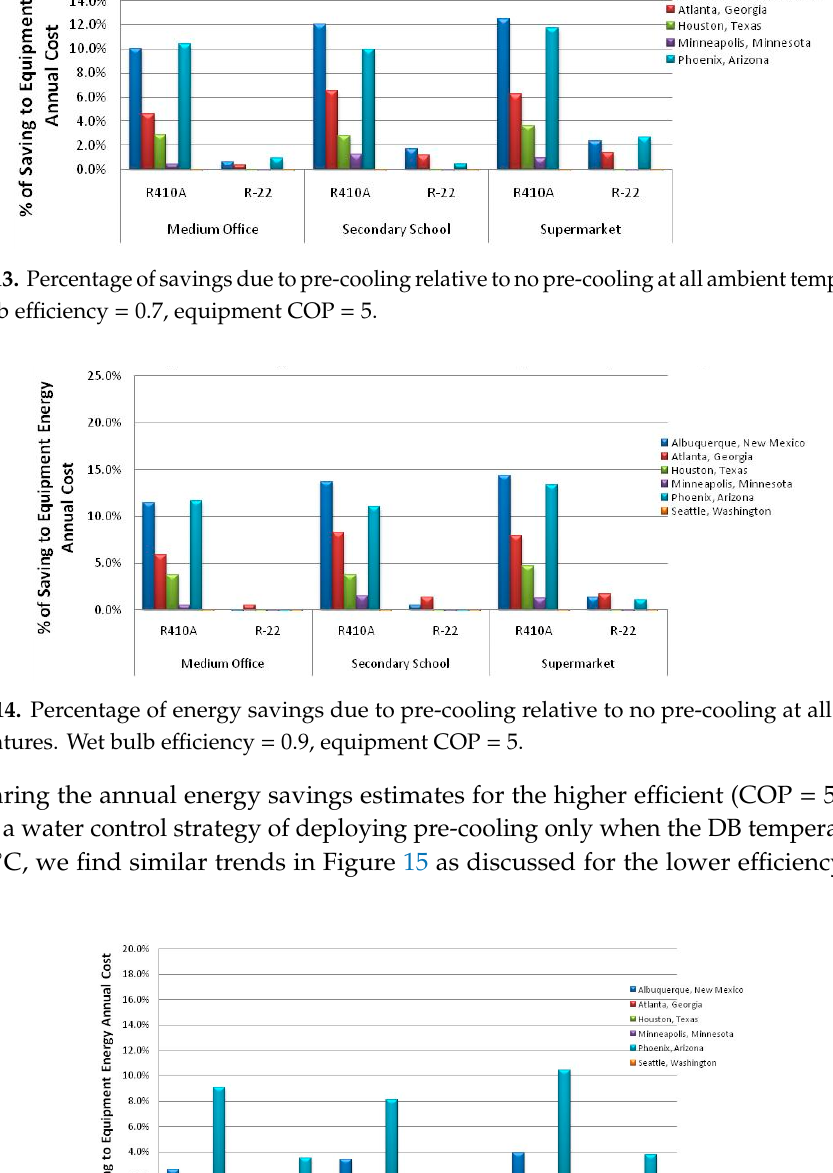
Figure 15. Percentage of energy savings due to pre-cooling relative to no pre-cooling when water is sprayed after ambient temperature is equal to or exceeds 90 °F/32.2 °C. Wet bulb efficiency = 0.9, equipment COP = 5.